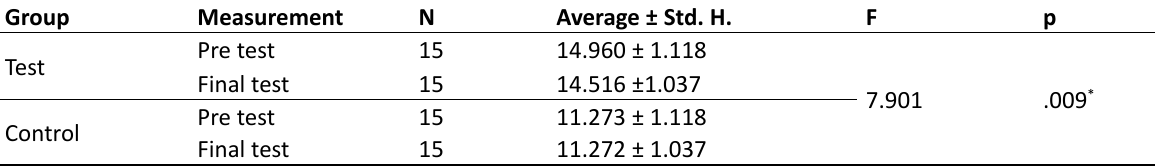
Table 6. Body Fat Percentage Values group x time interaction Group Measurement